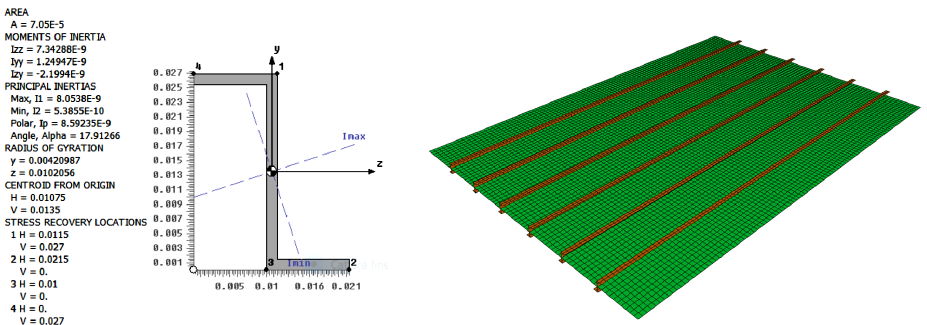
Figure 9. Conventional flat panel with symmetrical stiffeners